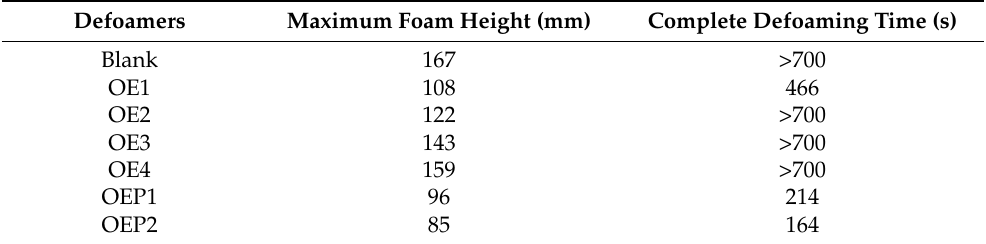
Table 3. Maximum foam heights and complete defoaming times of the samples of the polycarboxylate superplasticizer mixed with various